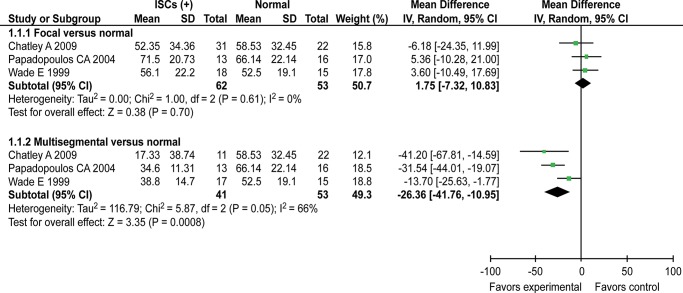
The forest plot of the focal, multisegmental group versus the normal group.